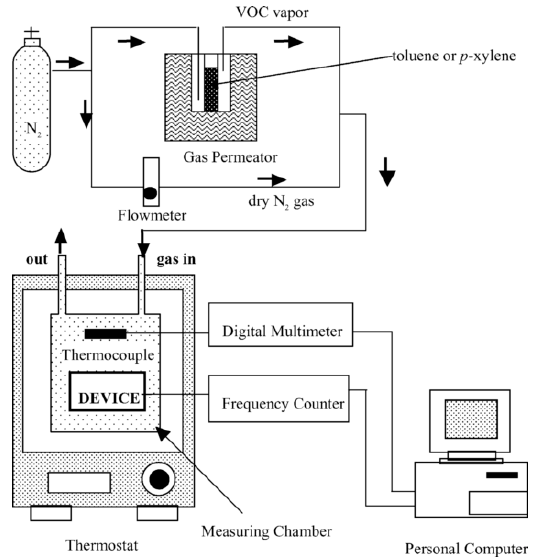
Figure 4. Experimental setup used to measure the volatile organic compounds sensor response [25].